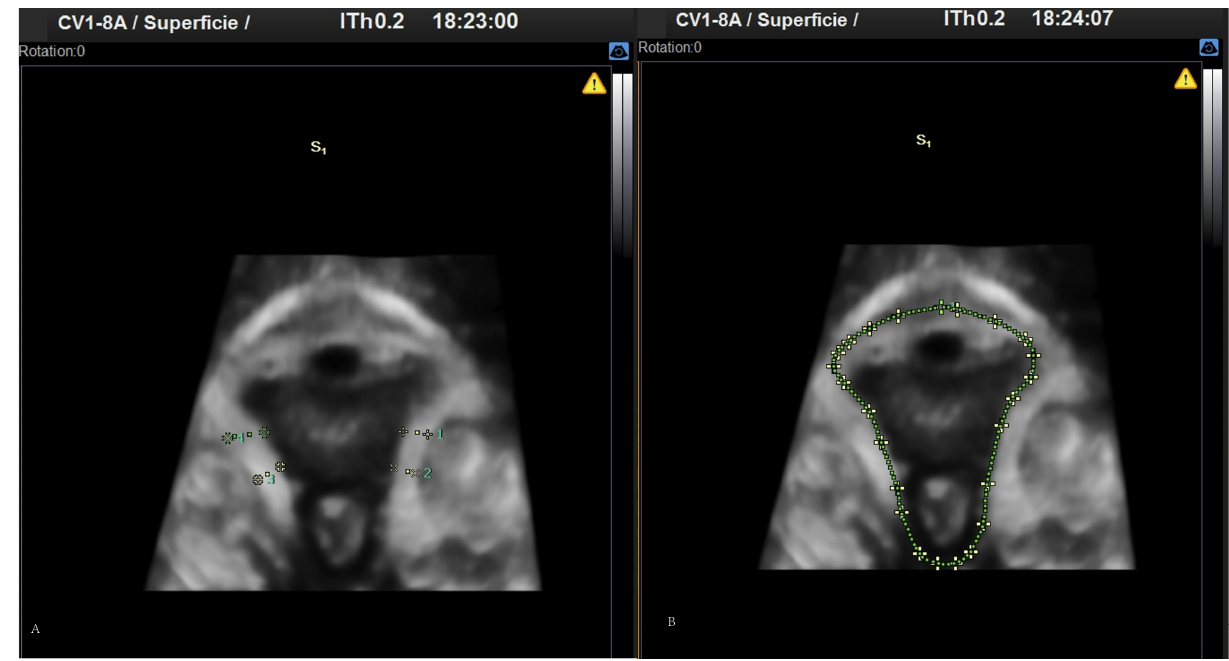
Figure 2. 3D images obtained by perineal ultrasound. ( A ) Pubovisceral muscle thickness. ( B ) Peri- neal hiatus area.